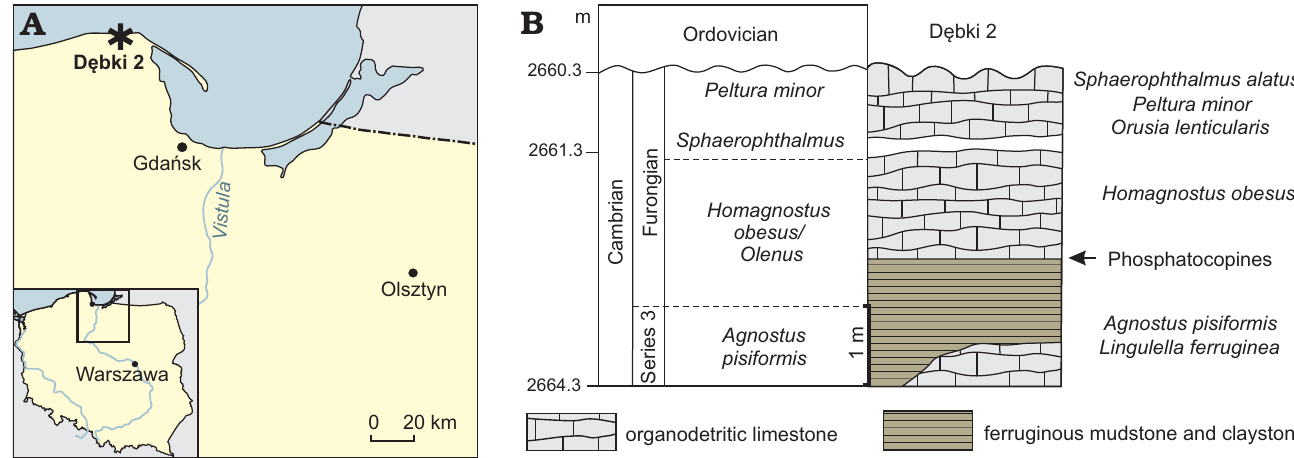
Fig. 1. A . Geographic location of study area in northern Poland, D ę bki (asterisk). B . Stratigraphic column showing location of the sample with